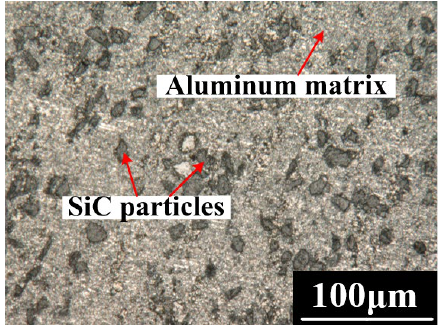
Figure 2. Microstructure of SiC p /Al composites.